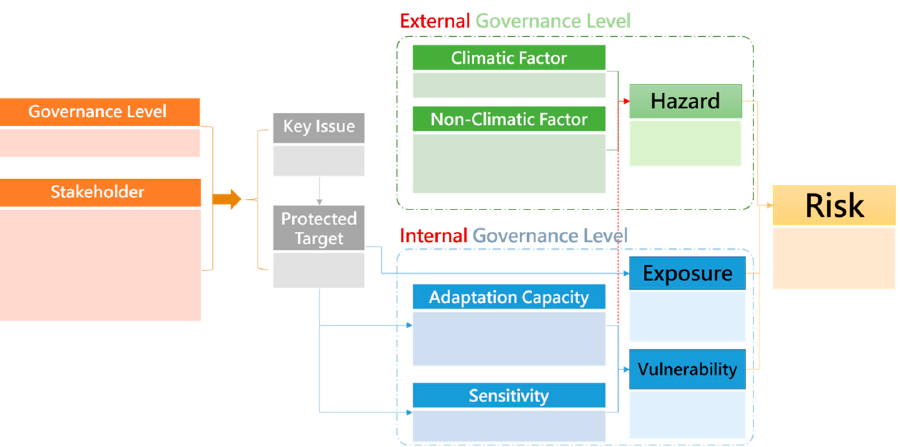
Figure 2. The proposed algorithm of climate risk assessment for investigating the relationship between factors.